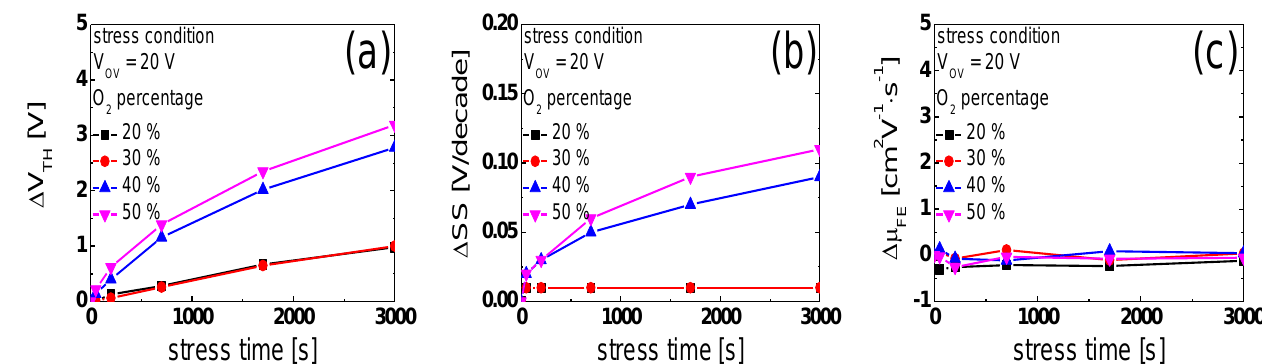
Figure 4. Time dependences of ( a ) ∆ V TH , ( b ) ∆ SS, and ( c ) ∆ µ FE values obtained from the IGTO TFTs prepared at different oxygen percentages under PBS after every stress time.